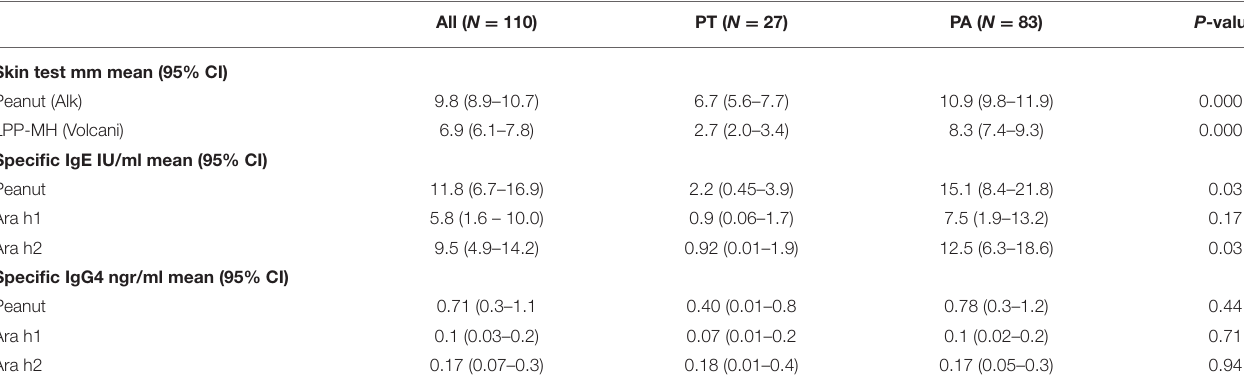
TABLE 2 | Skin tests, specific IgE and IgG4 to peanuts and peanut allergenic proteins, in 110 preschool children previously diagnosed with IgE mediated peanut